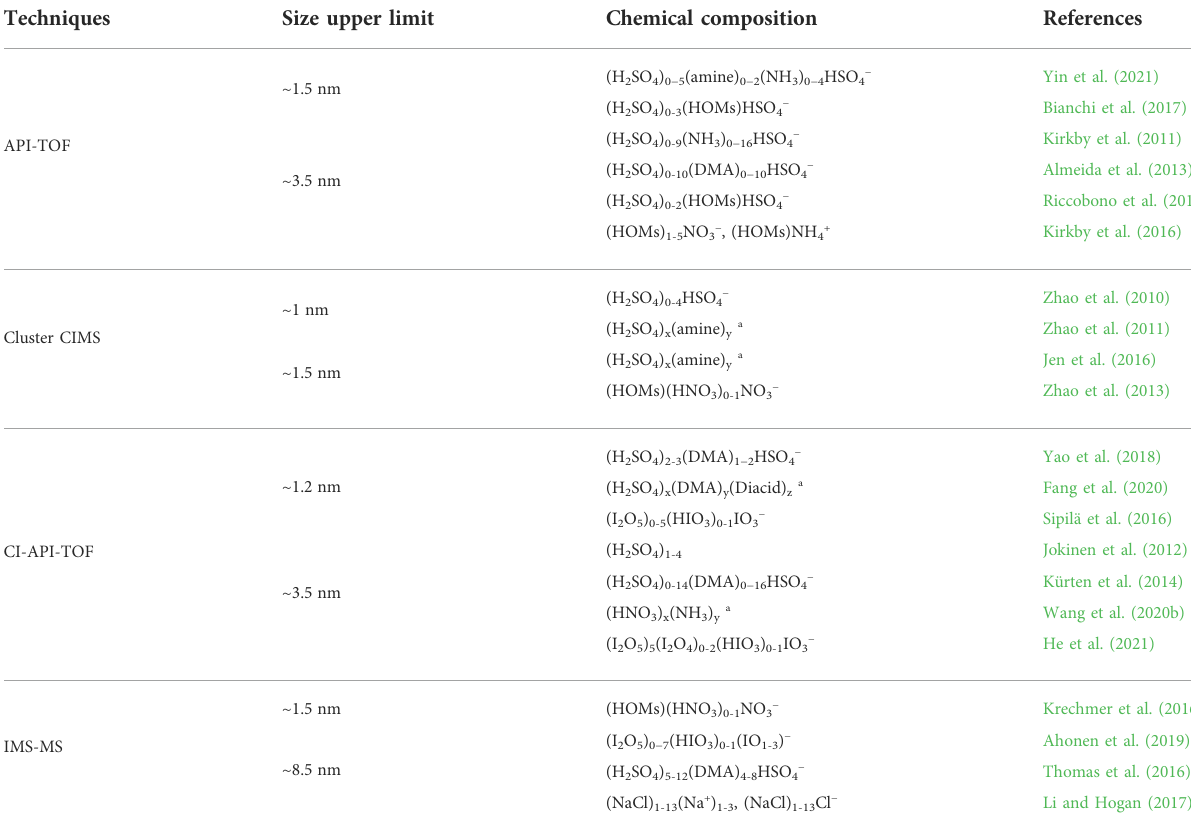
TABLE 2 The direct techniques used in measurements of cluster chemical